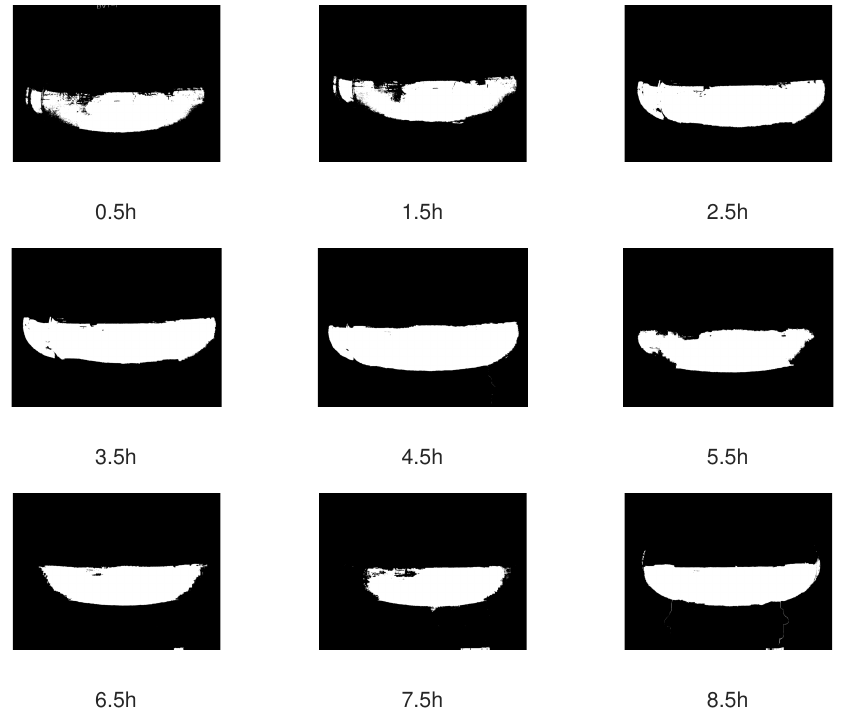
Figure 5. Result of applying Algorithm